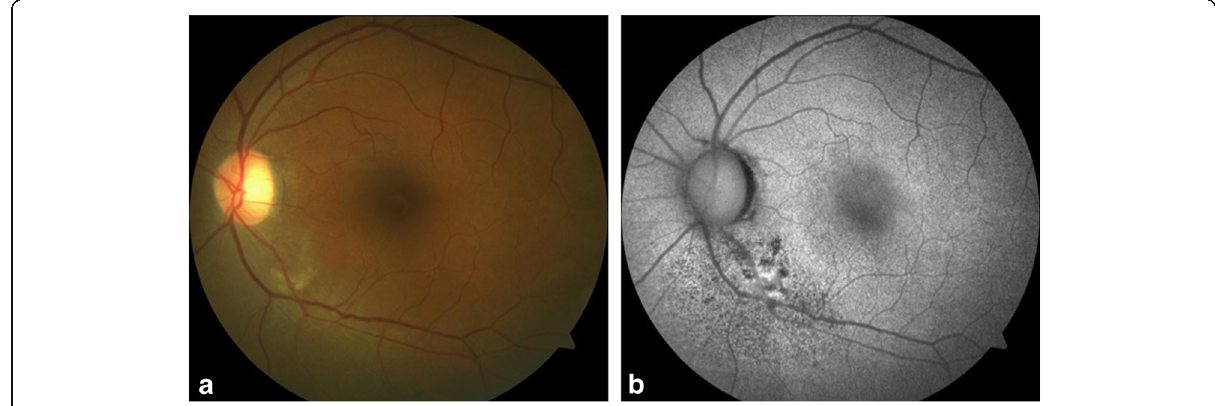
Fig. 6 a Fundus photograph of the left eye showing healed retinochoroiditis lesion with chorioretinal atrophy patches. b Fundus autofluorescence of the left eye showing hypoautofluorescent spots surrounding the predominantly hyperautofluorescent lesion. (12th